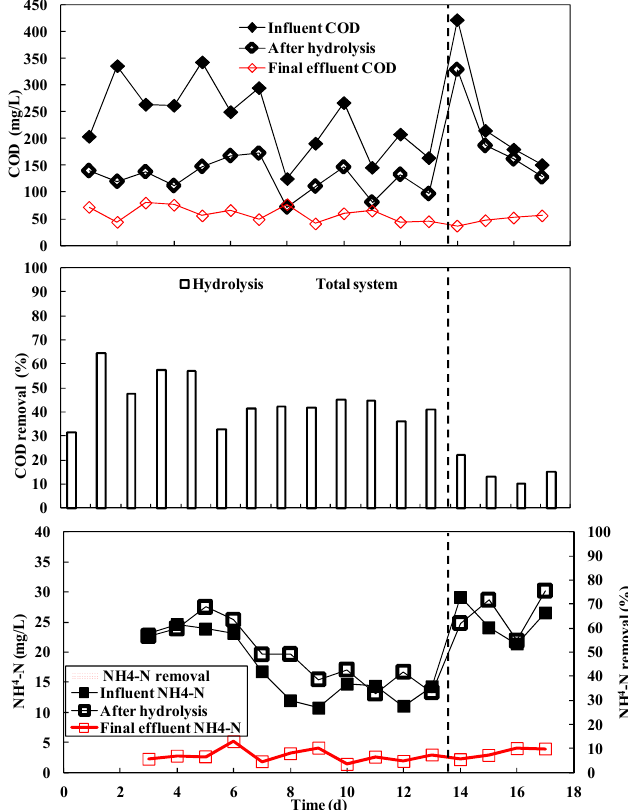
Figure 3. COD and NH 4+ ‐ N concentration of the influent and effluent and their removal efficiencies during the hydrolysis ‐ aerobic process (stages III and IV).